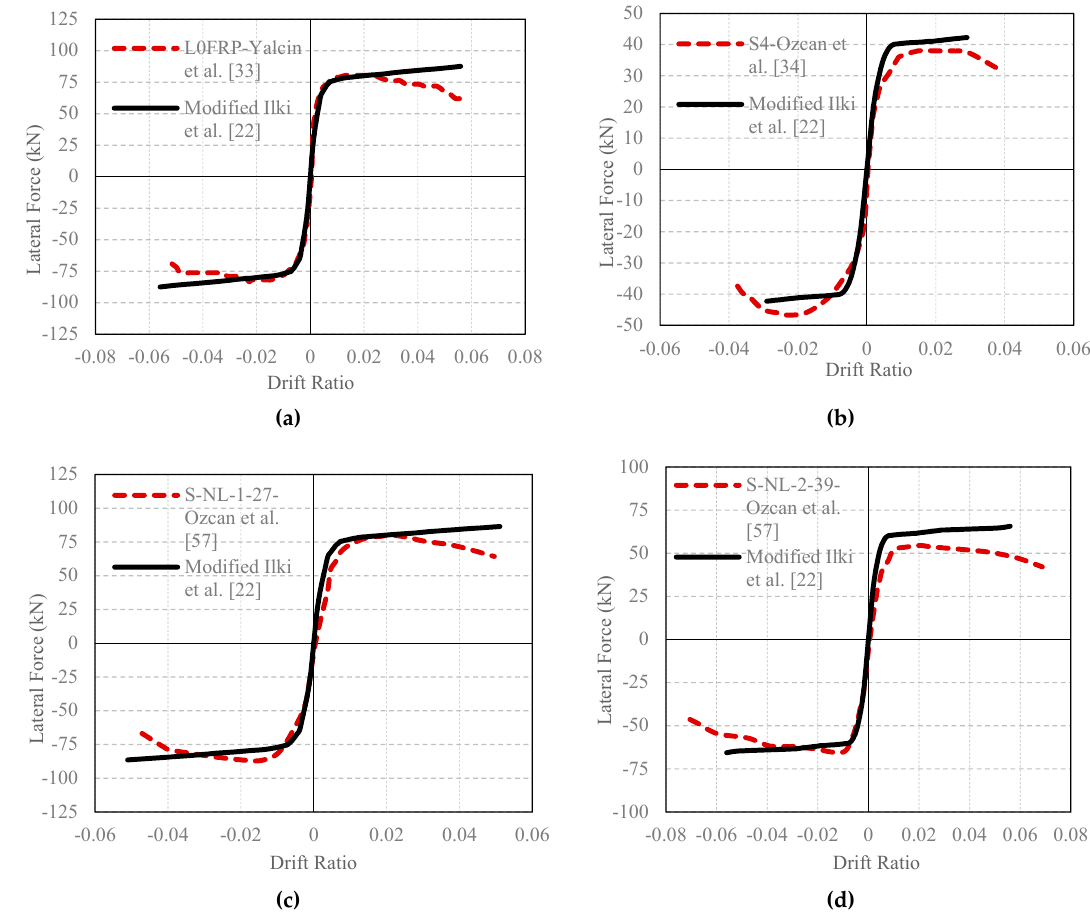
Figure 15. Comparison of the existing experimental results and analytical envelop relationships (modified from the Ilki et al. [22] model): ( a ) L0FRP, ( b ) S4, ( c ) S-NL-1-27 and ( d ) S-NL-2-39.